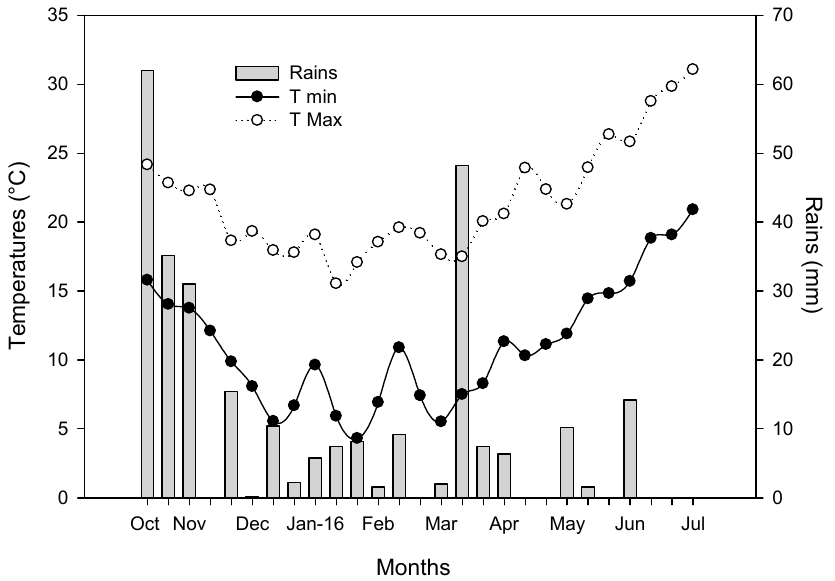
Figure 2. Air temperatures (as mean value over three decades) and rains (as sum value of three decades) during the growing period at the experimental site.